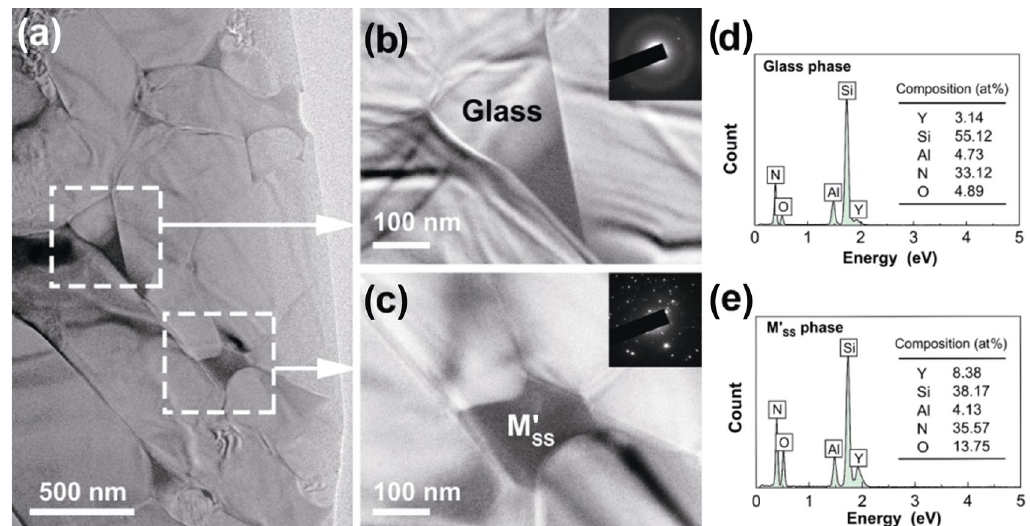
Fig. 9 TEM images and EDX analysis of sample Y3: (a) low-magnified morphology, (b) glass phase (triple junction), (c) M' SS phase, (d) EDX data of glass phase, and (e) EDX data of M' SS phase.